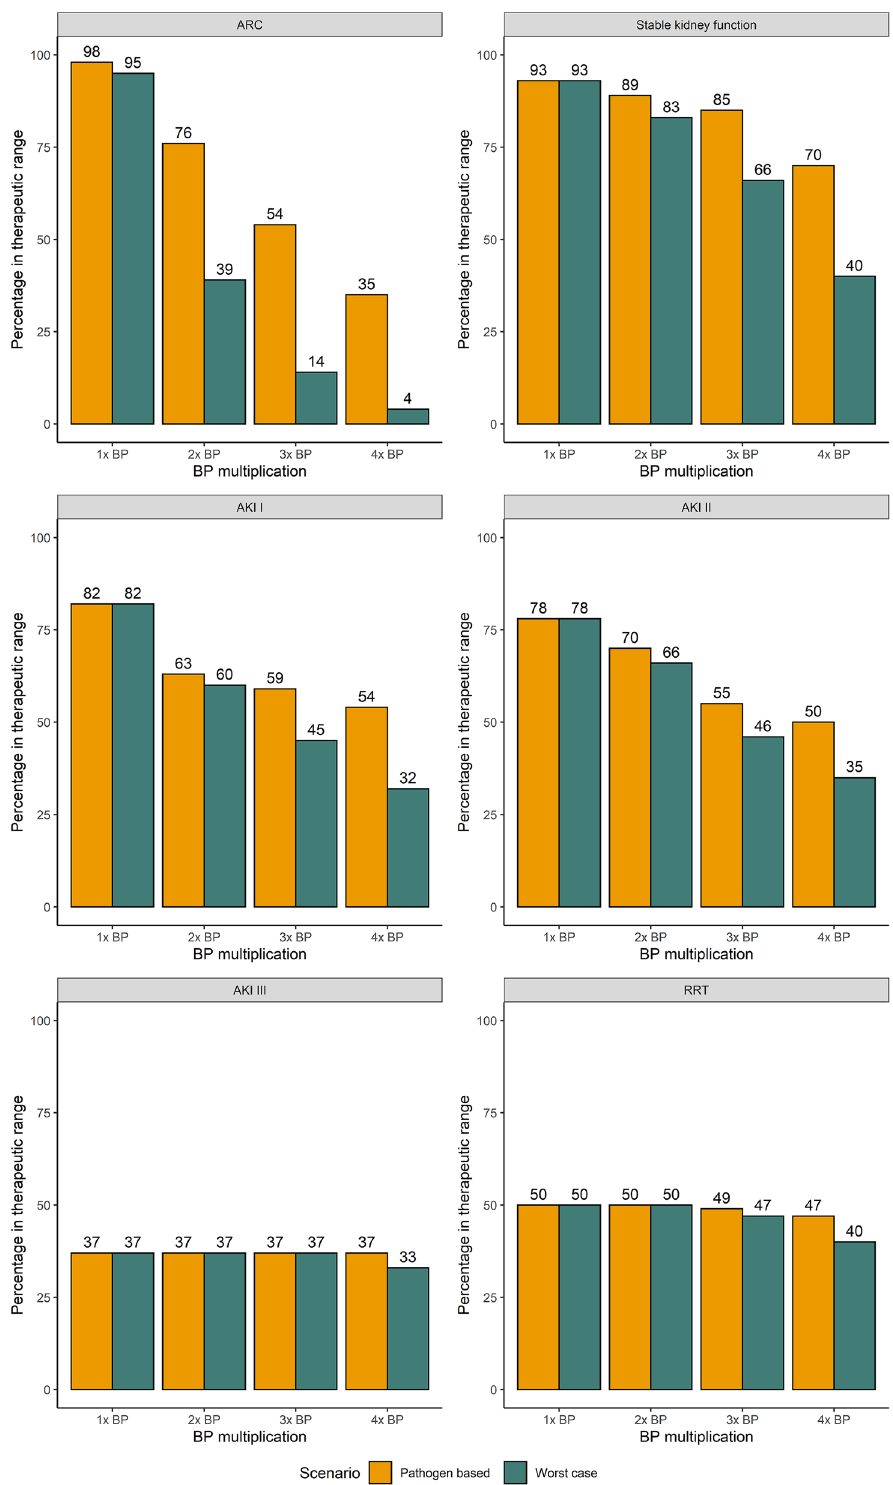
Fig. 5 Percentage of samples within the therapeutic range for TZP according to the different BP multiplications and renal